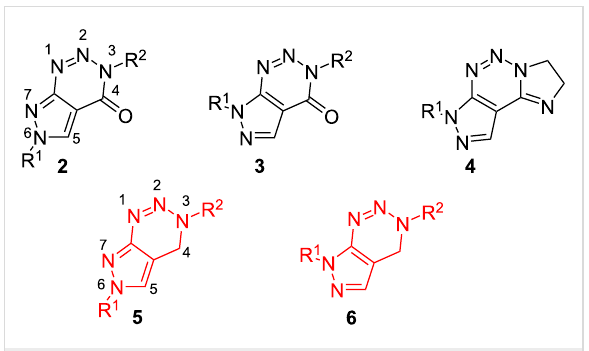
Figure 1: Structural differences of several known ( 2 – 4 ) and so far unknown ( 5 and 6 ) pyrazolo[3,4- d ][1,2,3]-3 H -triazine derivatives.